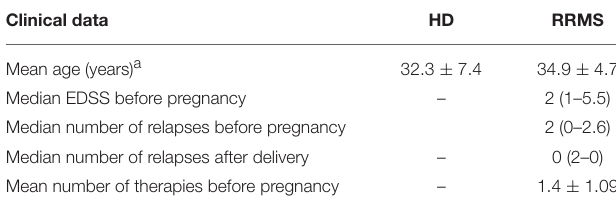
TABLE 1 | Patients’